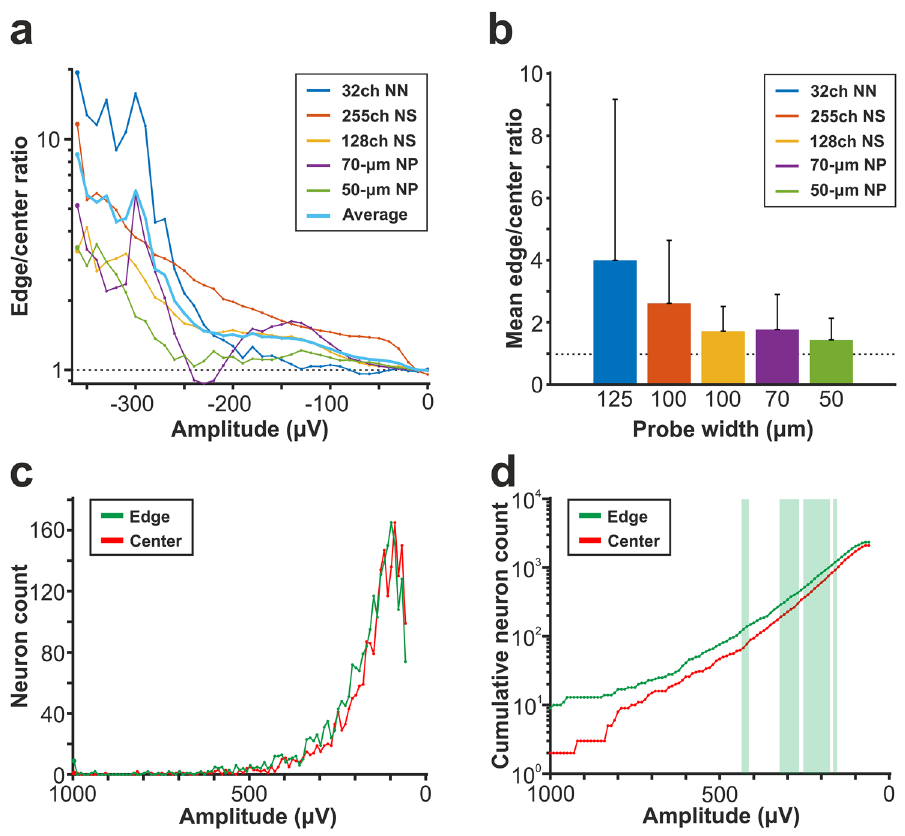
Figure 7. Summary of the recording performance comparison of edge and center sites. ( a ) Ratio of the probability density values of edge sites to center sites calculated in the negative amplitude range from 0 μV to − 1000 μV, for each probe type. The larger first dot represents the sum of the probability values computed in the range below − 350 μV. The dashed line indicates the position where the probability of edge samples and center samples is equal. The thick line with light blue color shows the average of the five probes. ( b ) Values illustrated in ( a ) averaged over the whole negative amplitude range for each probe type (mean ± standard deviation). Probes are ordered by shank width. ( c ) Distributions of the spike amplitudes of all single units recorded on edge (green, n = 2351 units) and center (red, n = 2102 units) sites. Note that the direction of the x-axis is reversed. ( d ) Reverse cumulative distributions of spike amplitudes calculated from ( c ). Green shaded areas indicate amplitudes with significantly higher numbers of edge units. In ( c ) and ( d ), amplitudes start at 60